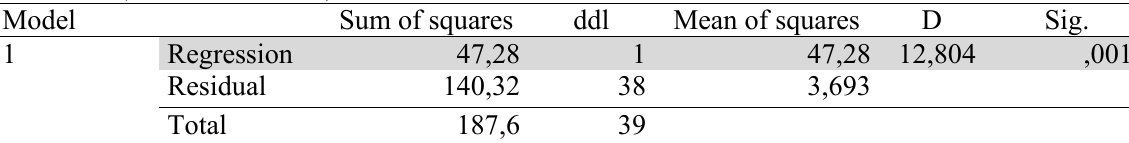
ANOVA b (Relation Ab →